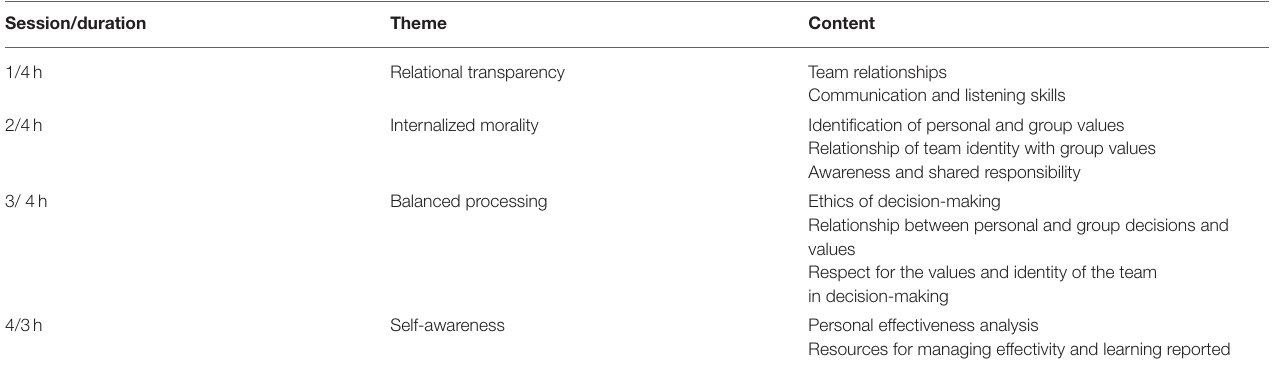
TABLE 1 | Programming, themes, and contents of the authentic leadership program.